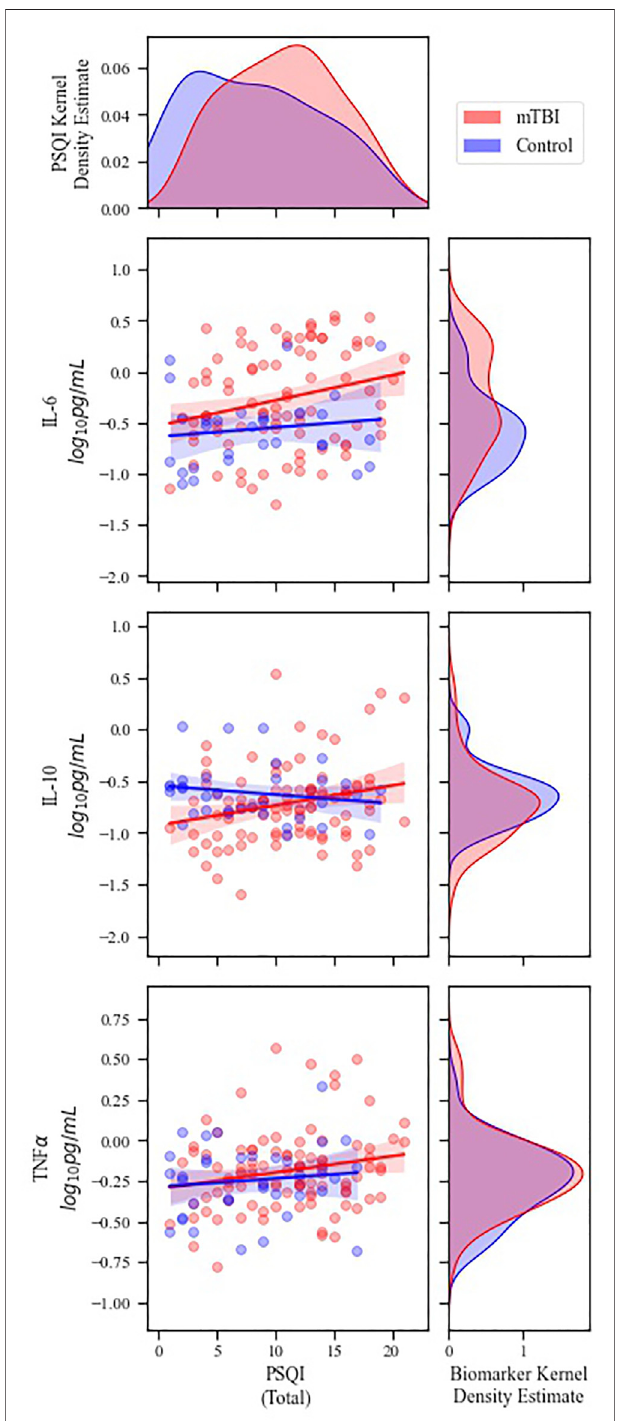
FIGURE 1 | Correlations between PSQI score and EV-derived in fl ammatory cytokine concentrations. Main plots) Scatterplots of PSQI versus EV cytokine concentrations.Linesrepresentlinearbest fi twith95%con fi denceintervals.Signi fi cant correlations were demonstrated between PSQI and all three cytokine levels in the mTBI cohort (see Table 2 for detailed statistics). Marginal plots) Kernel density estimates representing the distribution of PSQI scores (top) and cytokine biomarker concentrations(right)foreachcohort.Blue (cid:1) controlpatients;Red (cid:1) mTBIpatients.For clarity, data are visualized without values below the lower limits of quanti fi cation.